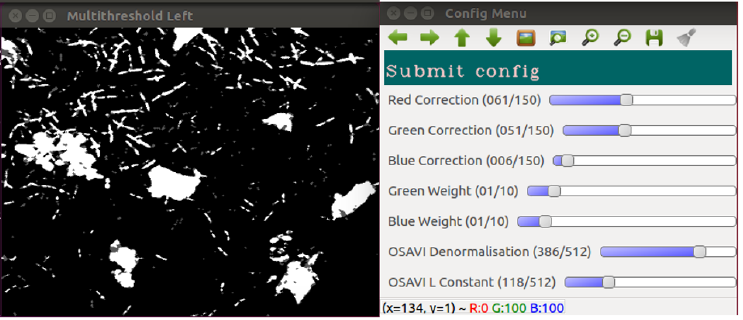
Figure 8. Screenshot of the system during calibration process for plant identification, showing a desirable output following